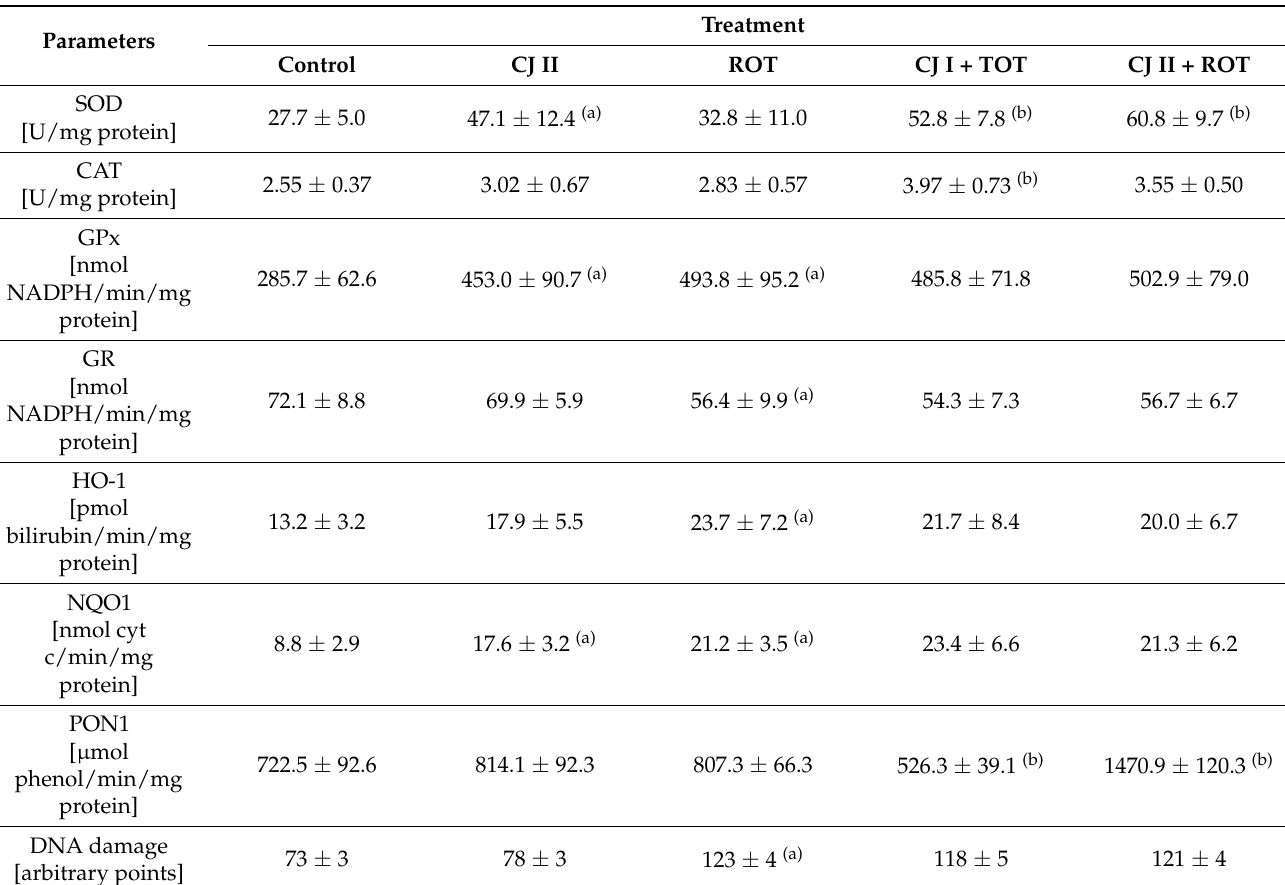
Table 2. Effect of cranberry juice (CJ) on oxidative stress markers in the liver of rotenone (ROT)-injected rats.